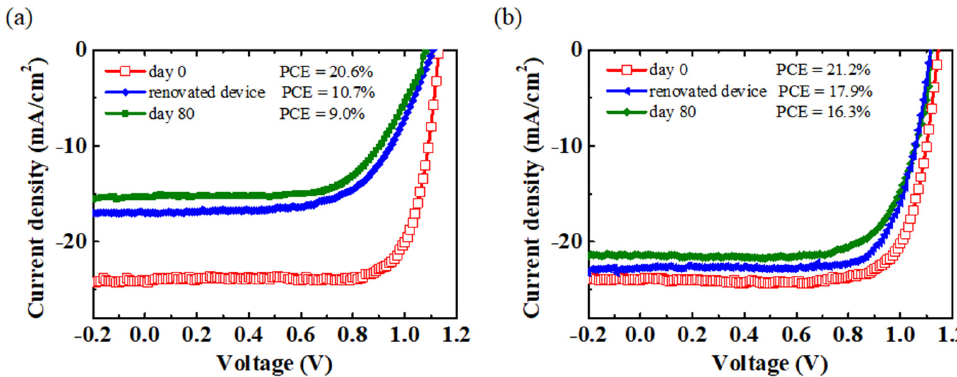
Figure 5. The JV curves change in ( a ) spiro-OMeTAD and ( b ) PMMA (2 mg/mL): spiro − OMeTAD based original, long-term storage and renewed devices in the air environment.